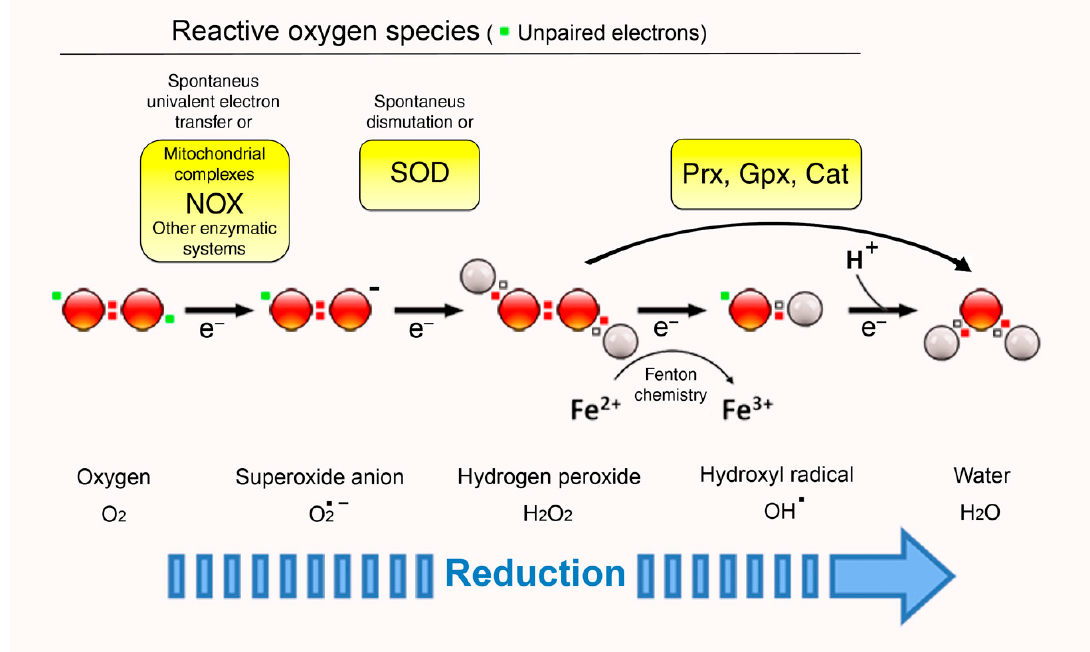
Figure 1. Major producing and removal pathways for reactive oxygen species (ROS). The sequential steps of the univalent reduction of molecular oxygen (O 2 ) to water (H 2 O) leading to the generation of several ROS intermediates are shown. Diverse redox enzymatic systems, mainly mitochondrial respiration complexes and membrane-residing NADPH oxidases (NOXes), can convert O 2 into superoxide (O 2• − ). Superoxide dismutases (SOD) catalyze the dismutation of superoxide (O 2• − ) into H 2 O 2 and O 2 . H 2 O 2 can be reduced directly to water by peroxiredoxins (Prx), glutathione peroxidases (GPX), or catalases (CAT). Alternatively, hydroxyl radicals (OH • ) are generated from H 2 O 2 in the presence of reduced transition metals, such as Fe 2+ (Fenton reaction). Red squares and green squares represent paired and unpaired electrons, respectively, in the oxygen atom. White squares represent the electron provided by hydrogen atoms.